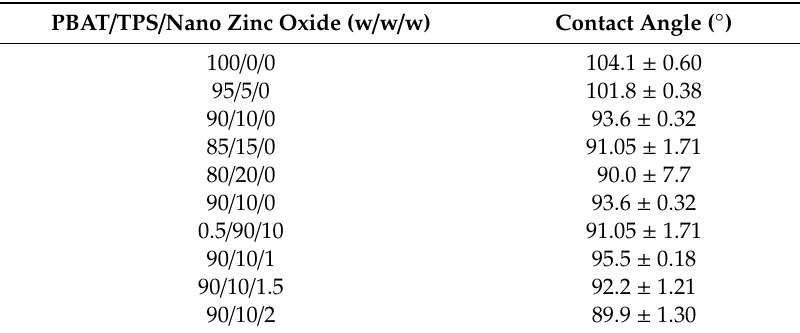
Table 1. Water contact angles of composite